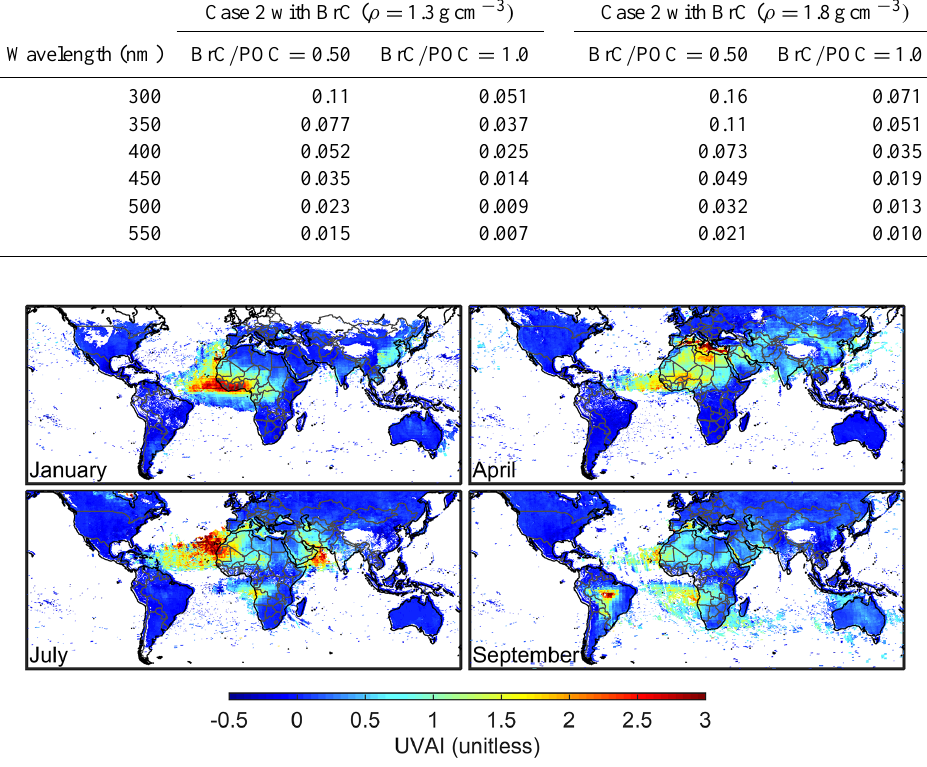
Figure 4. Monthly mean UVAI values for 2007 simulated for OMI observing conditions using the vector radiative transfer model VLIDORT coupled with GEOS-Chem aerosol fields for case 2, which assumes the presence of absorbing BrC aerosol. White indicates clouds or snow